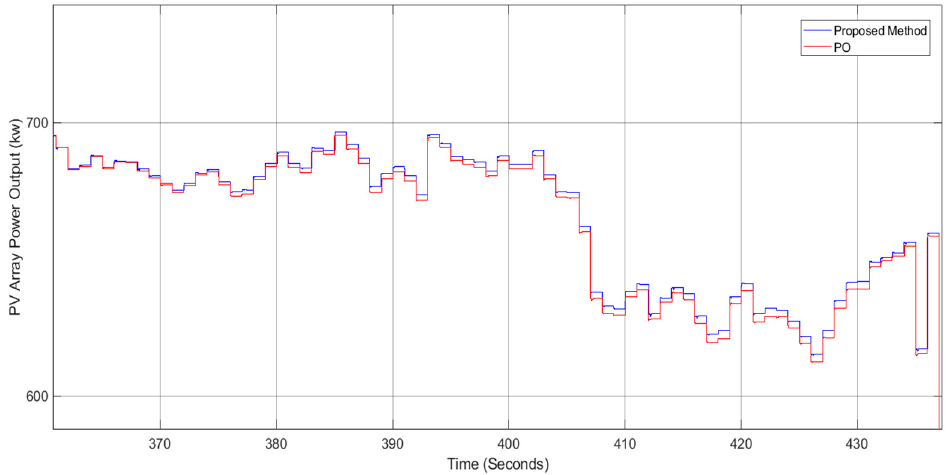
Figure 9. Sample of the output power of the proposed method and the PO method for a period (370–430) of time on a cloudy day.